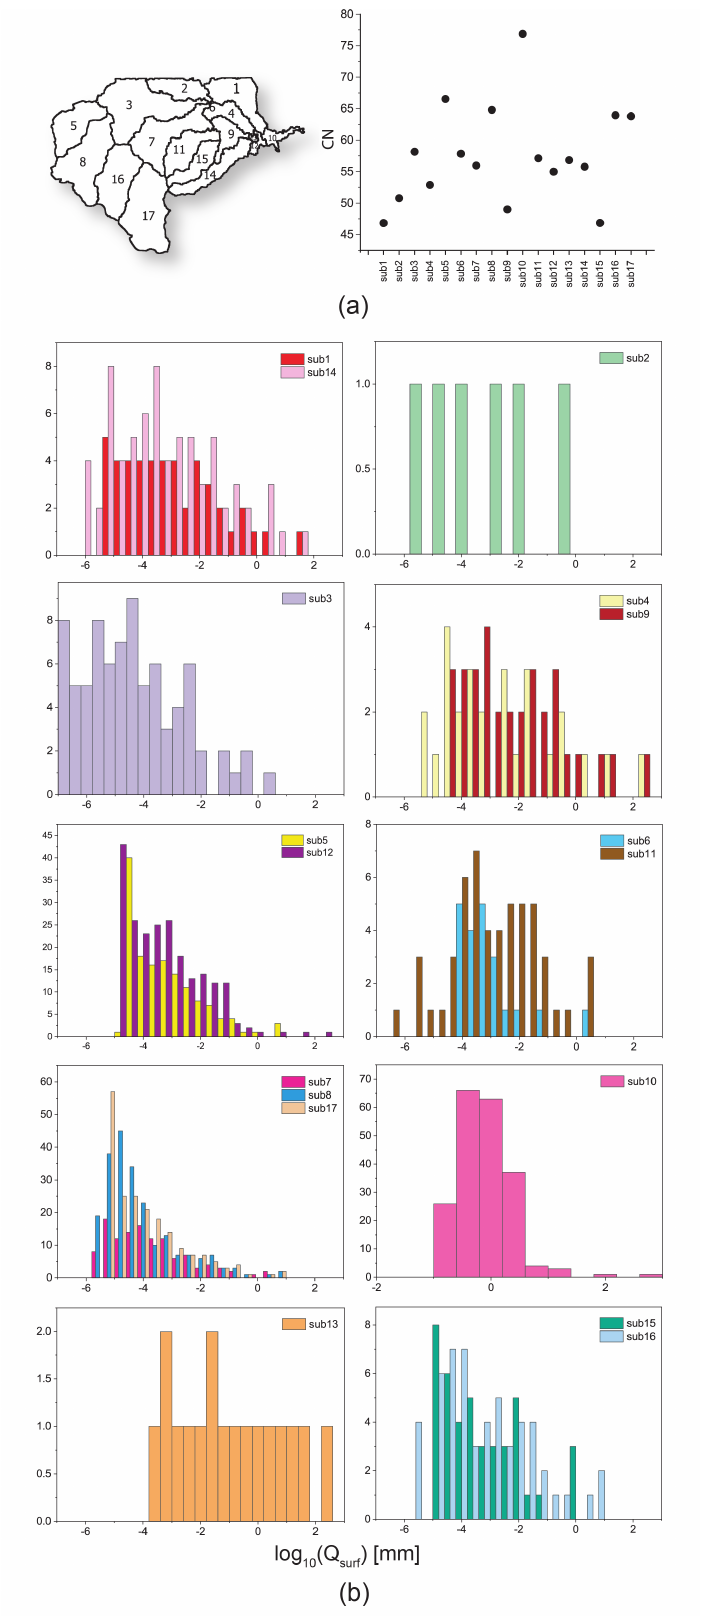
Figure 9. Average curve number associated with each subbasin ( a ) and histogram of the highest fifth percentile of the daily Q surf for each subbasin ( b